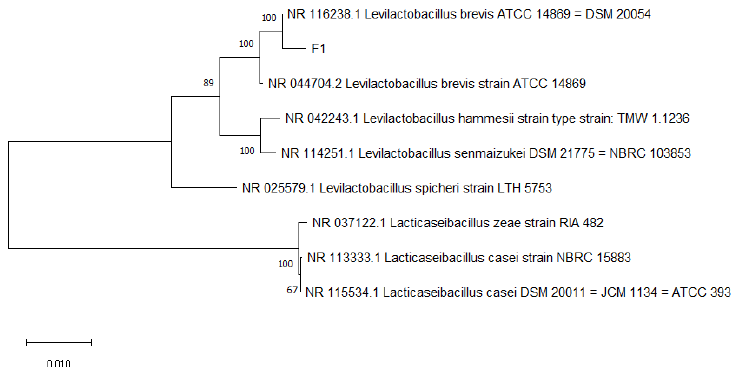
Figure 2. F1 gene development